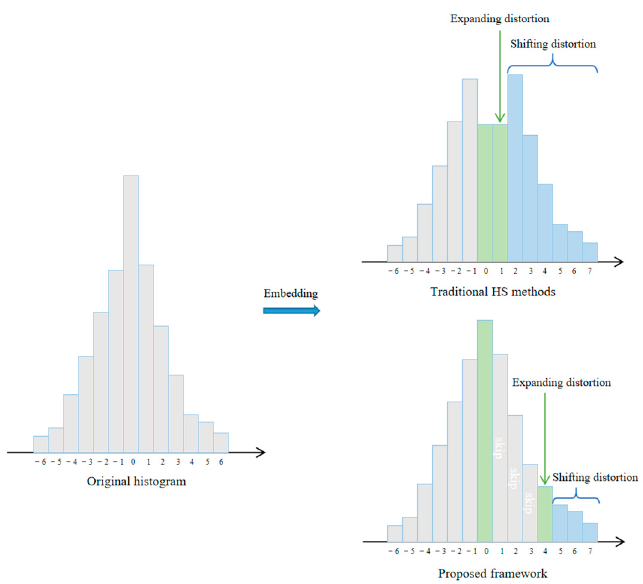
Figure 5. The comparison of the traditional HS methods with the proposed framework .